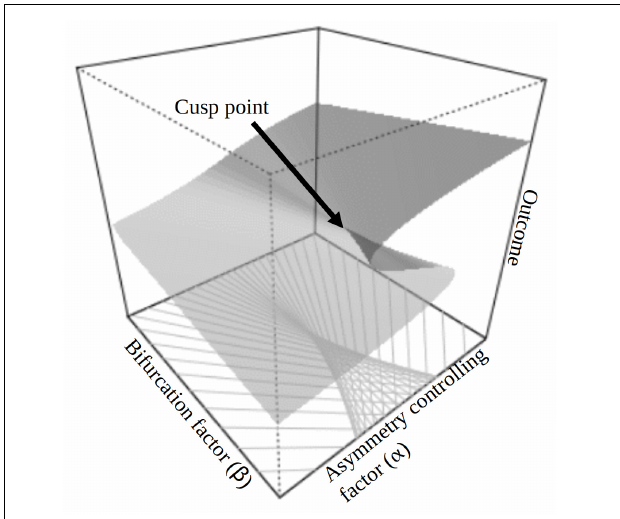
FIGURE 1 | Cusp catastrophe